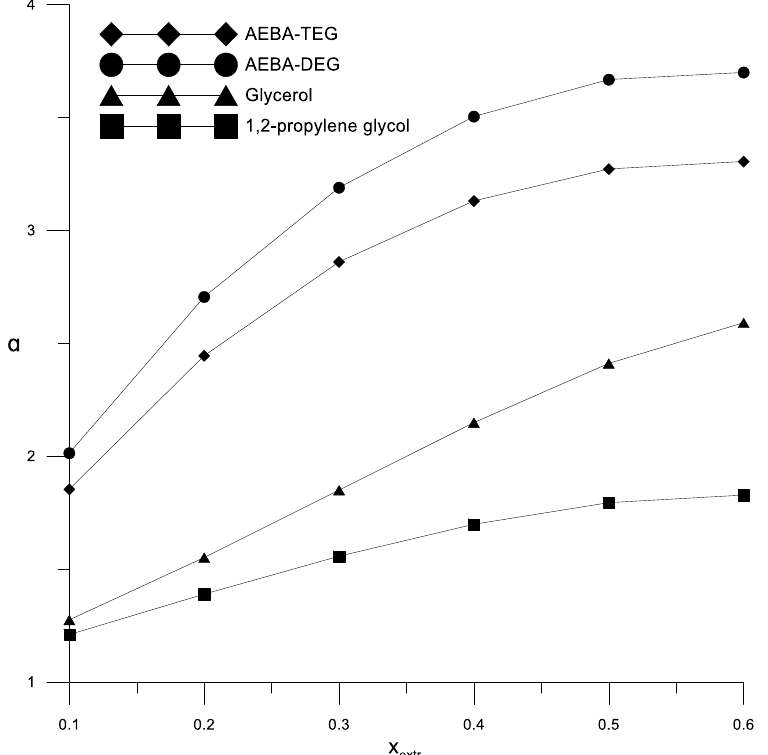
Figure 9. The coefficients of the relative volatility depending on the concentration of the extractant at the azeotropic point of the isopropanol–water mixture.